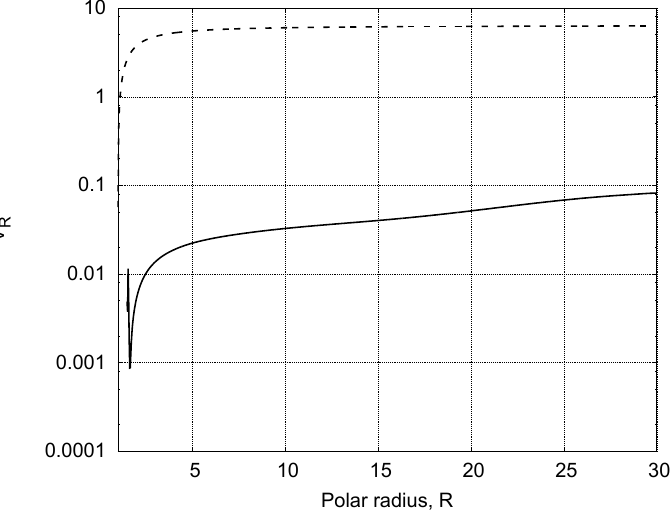
Figure 11. Dependence of the poloidal velocity on the polar radius R at the equator (solid line) and at the axis of rotation (dashed line), ω =